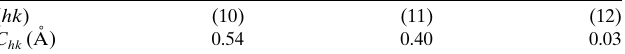
Table 1 Magnitudes of C hk in graphene.